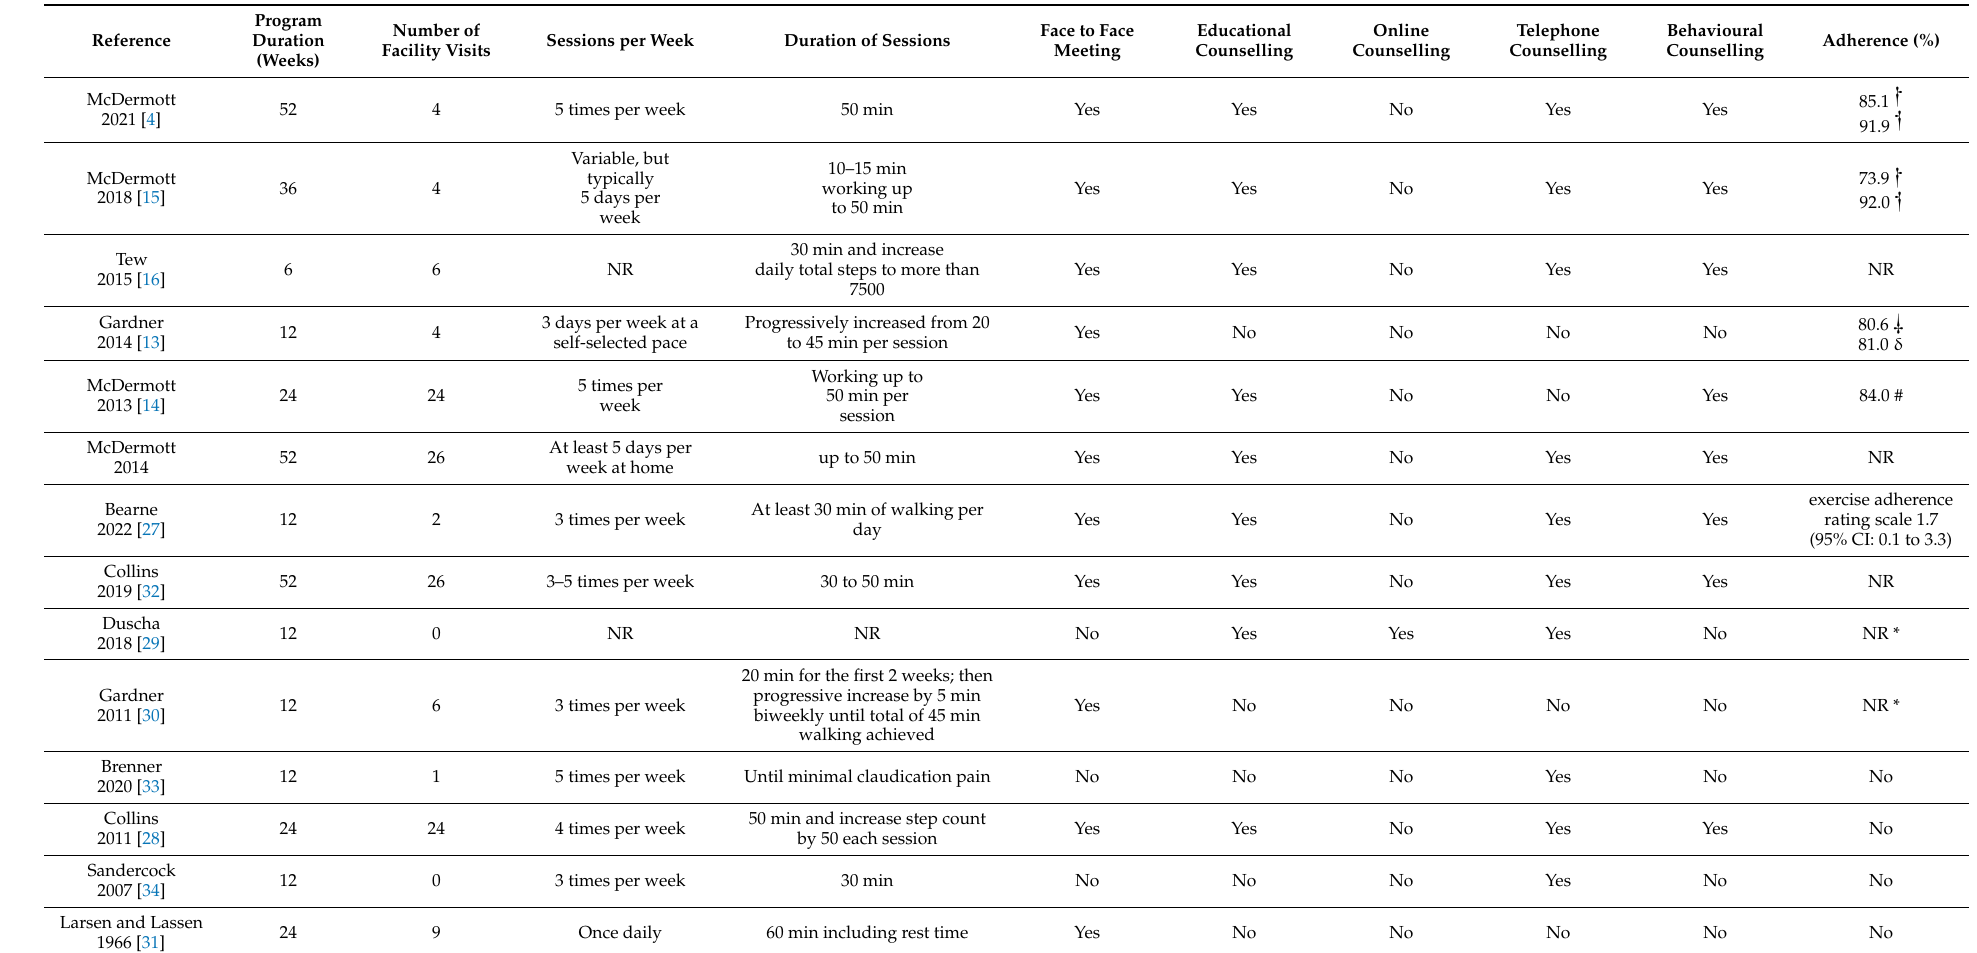
Table 2. Structure of the tested exercise program.